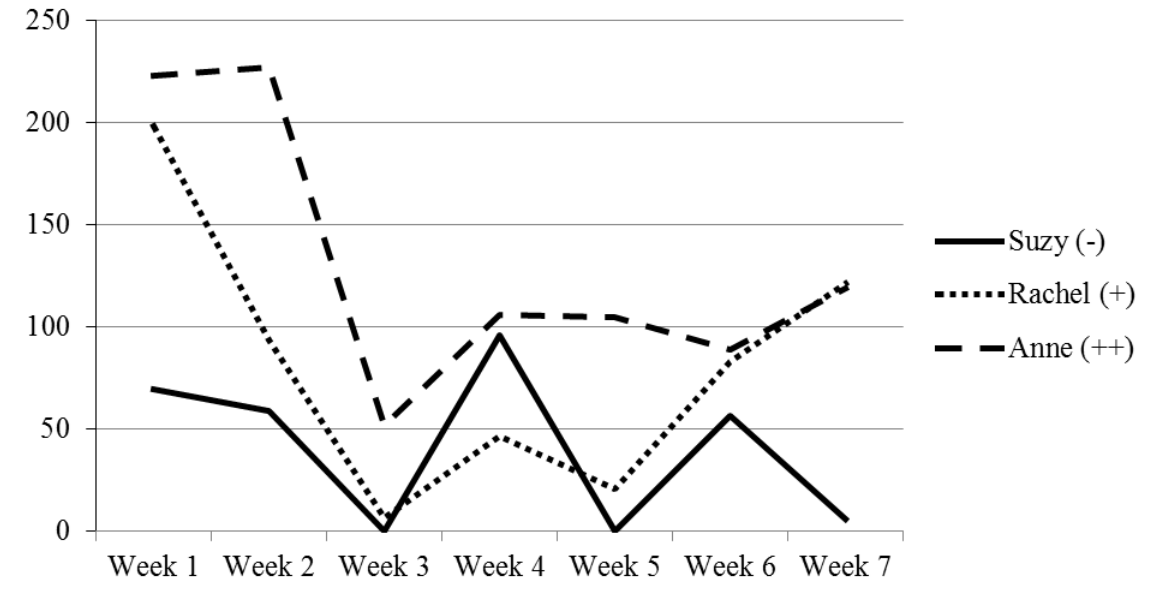
Figure 7 . Time Spent on Pages Across Time During the First Seven Weeks of the